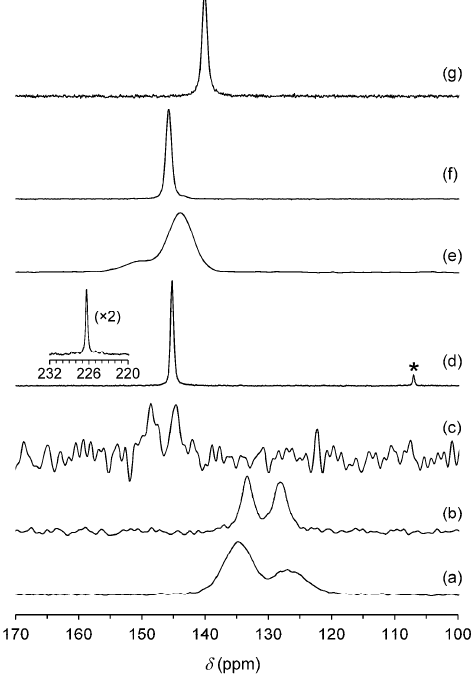
Figure 3. 13 C{ 1 H} CP MAS NMR spectra of ( a ) oxidized derivative 1 OD , ( b ) hybrid 3 , ( c ) 1,2,4-trz, ( d ) complex 2 , ( e ) oxidized derivative 2 OD , ( f ) hybrid 4 , and ( g ) dinuclear complex 5 . The inset shows the single 13 C resonance observed for the CO groups of 2 ( d ). The asterisk denotes a spinning sideband.